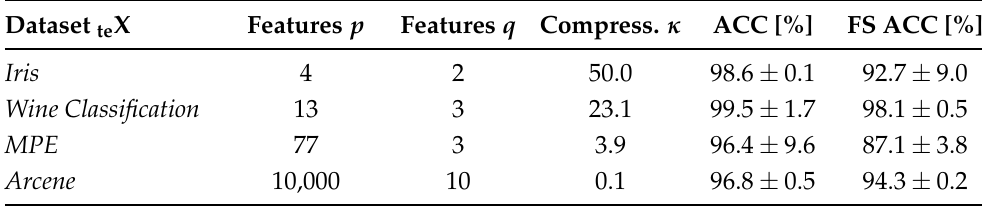
Table 3. Overview of the compression of the input using FeaSel-Net and the resulting classification performance after 250 epochs of training with only three input features.